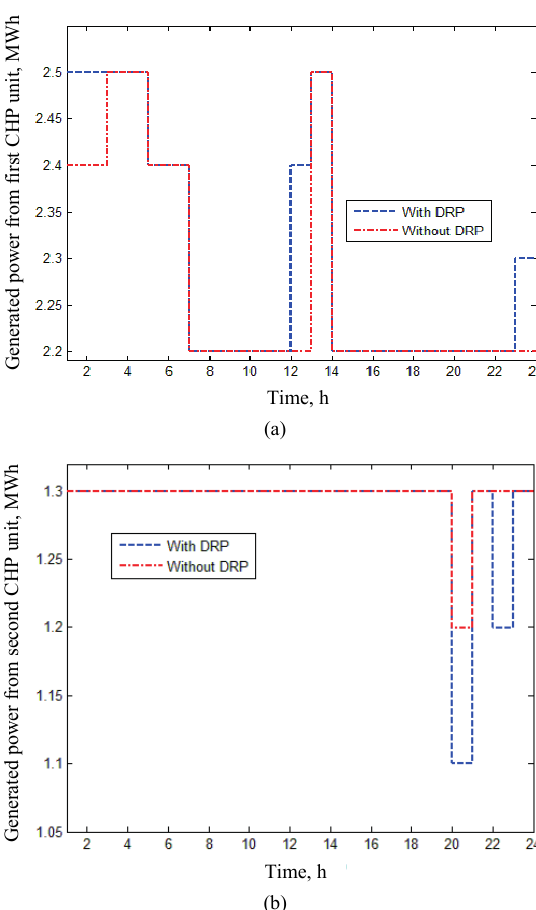
Fig. 6. Electrical generated by CHP units: (a) CHP 1 and (b) CHP 2. Fig. 7 presents the heat output of CHP unit 1 and CHP unit 2, respectively. As it was explained, the CHP units heat output is fully relying and dependent to their power output. Therefore, the heat output change in the CHP unit is in accordance with the power output of these